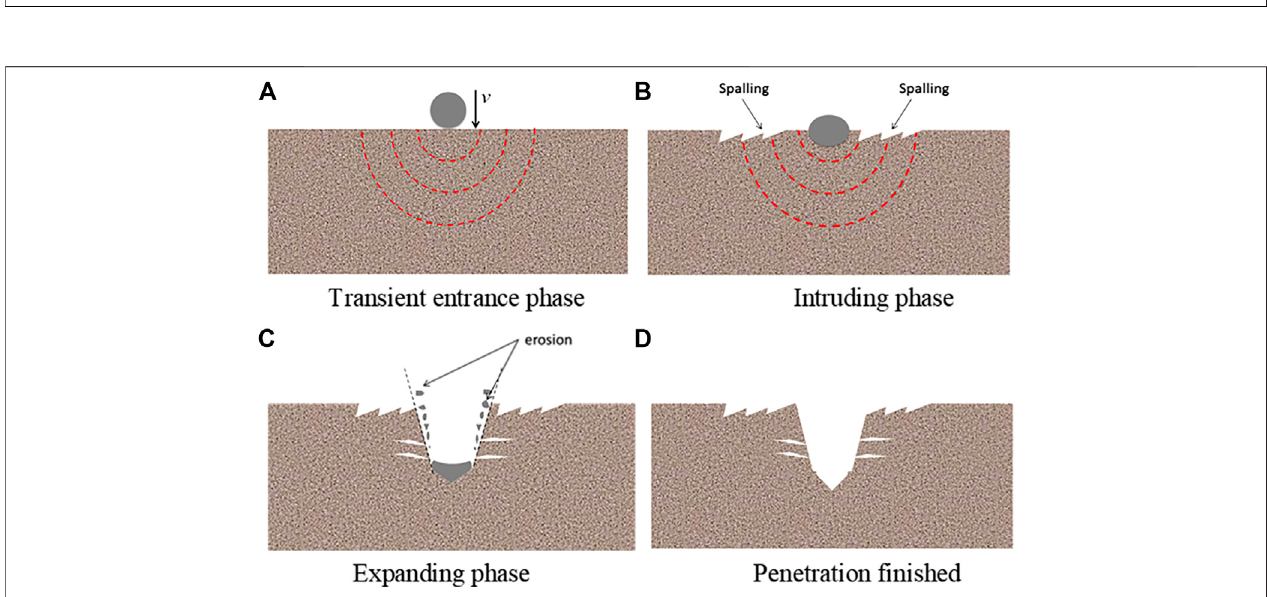
FIGURE 7 | Schematical diagrams of penetration process of low carbon steel target impacted by a tungsten ball (Zhao et al., 2015). (A) Transient entrance phase, (B) intruding phase, (C) expanding phase, and (D) penetration fi nished.